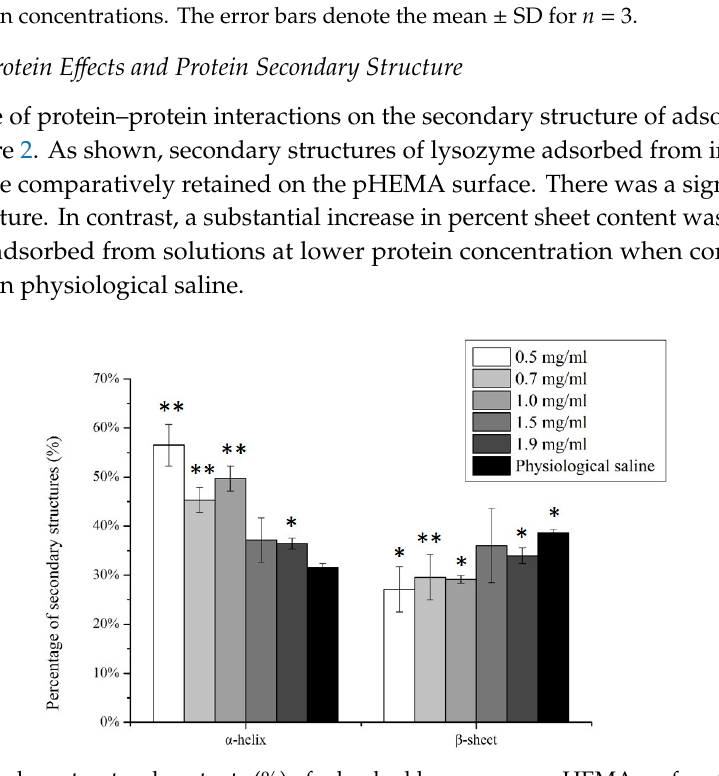
Figure 2. Secondary structural contents (%) of adsorbed lysozyme on pHEMA surface from di ff erent solution concentrations. The secondary structure of lysozyme measured in physiological saline solution was studied as the control. The error bars denote the mean ± SD for n = 3. *and ** represent p < 0.05 and p < 0.01,